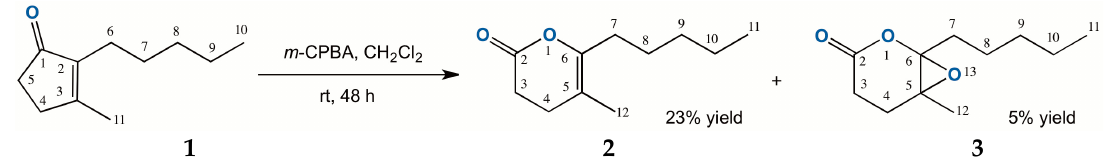
Figure 1. Oxidation of dihydrojasmone ( 1 ) with m -CPBA.